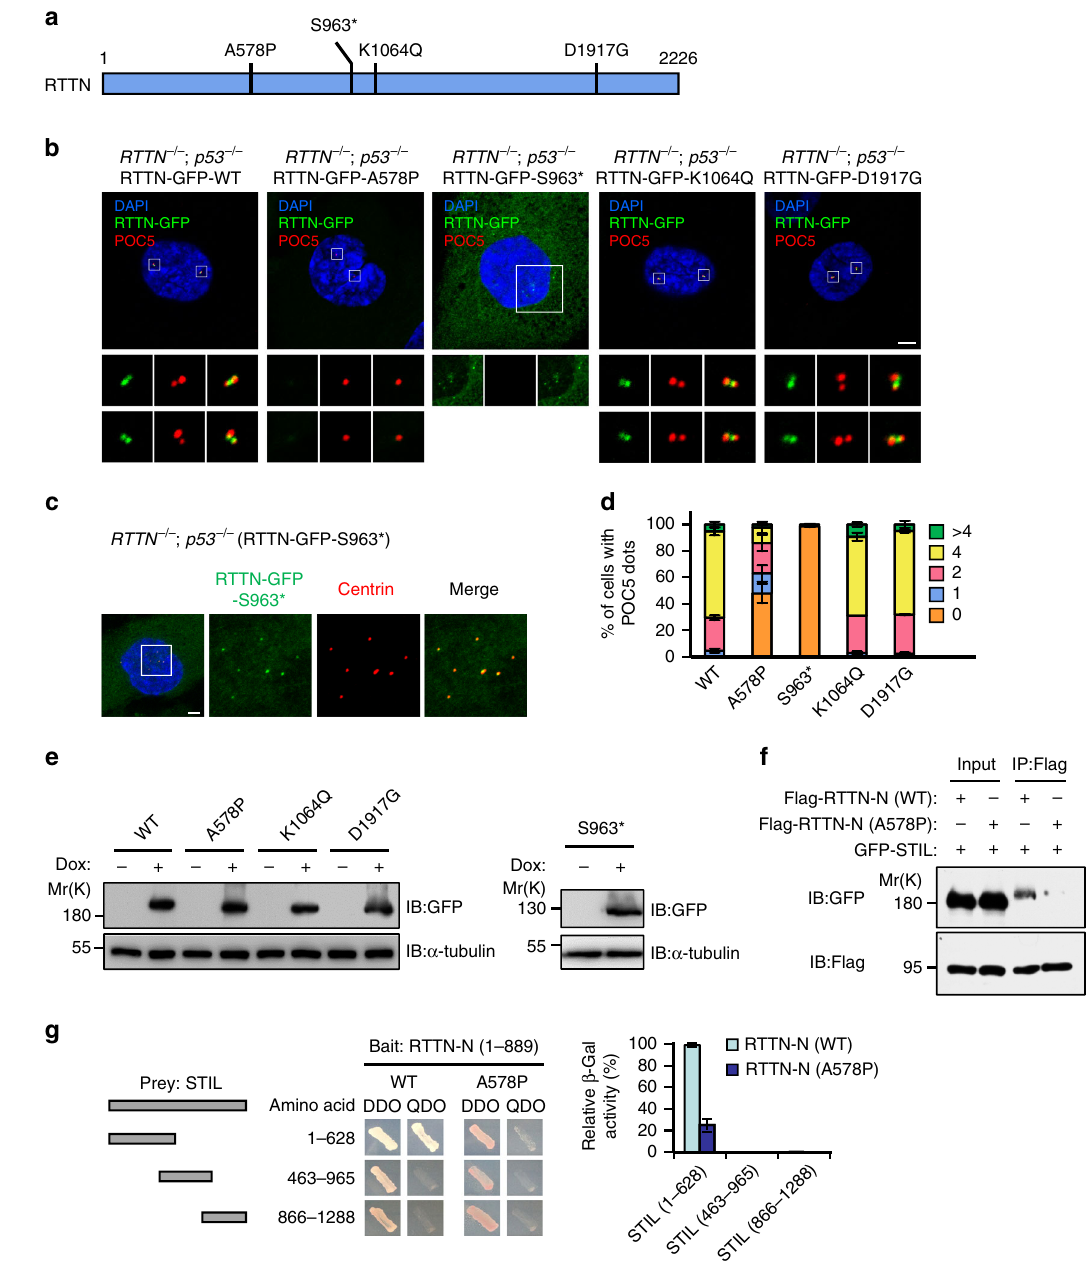
Fig. 7 The human microcephaly RTTN mutant, A578P, exhibits reduced binding to STIL and its expression perturbs centriole duplication. a Schematic representation of RTTN showing the positions of RTTN mutations that cause primary microcephaly. b , c RTTN − / − ; p53 − / − RPE1 cells that expressed doxycycline-inducible RTTN-GFP wild-type or mutant proteins (A578P, S963*, K1064Q, or D1917G) were synchronized by aphidicolin treatment for 24 h, and then released in fresh medium for another 15 h to allow progression to G2 phase. The cells were fi xed and stained with the indicated antibodies. d Histogram illustrating the percentages of cells exhibiting POC5 dots. Error bars represent the mean ± s.d. from three independent experiments ( n = 100/experiment). e RTTN − / − ; p53 − / − RPE1 cells that expressed doxycycline-inducible RTTN-GFP wild-type or mutant proteins were analyzed by IB using the indicated antibodies. f The naturally occurring A578P mutation of RTTN reduces the binding of the protein to STIL. HEK293T cells were co-transfected Flag-RTTN-N (WT) or Flag-RTTN-N (A578P) mutant with full-length GFP-STIL. Twenty-four hours after transfection, cell lysates were IP with anti-Flag and analyzed by IB using the indicated antibodies. g Yeast two-hybrid assay testing interactions between various portions of STIL (prey) and truncated RTTN-N (bait, both WT and A578P). Histogram illustrating relative β -galactosidase ( β -Gal) activity obtained in a liquid assay. The interaction between STIL (1 – 628) and RTTN-N (WT) was arbitrarily set to 100%. Error bars represent the mean ± s.d. from